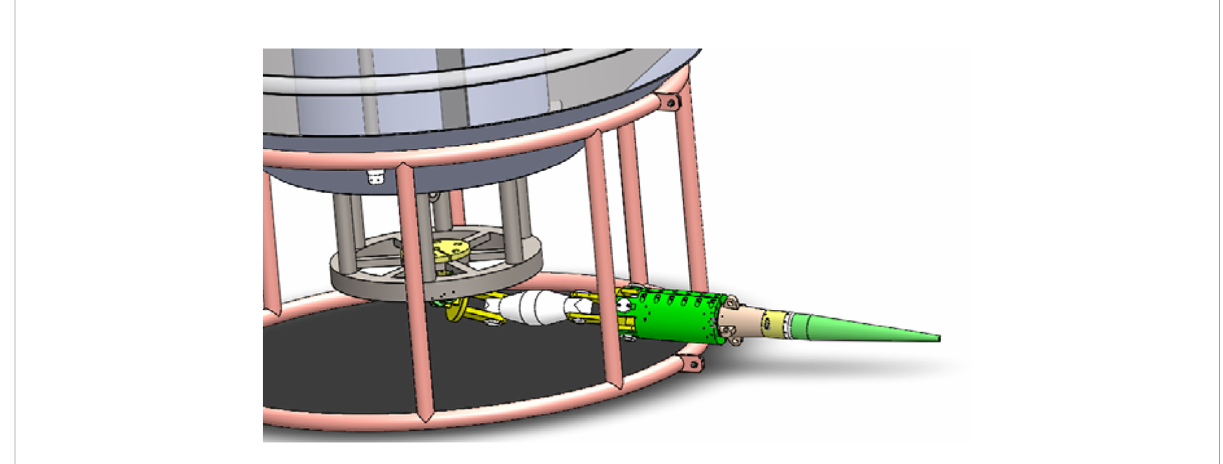
FIGURE 8 Connection of buoy and the fl exible connection